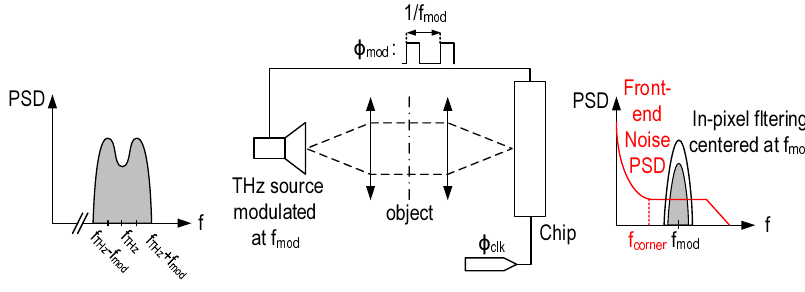
Figure 2. Noise reduction in CMOS THz imagers using source modulation and on-chip